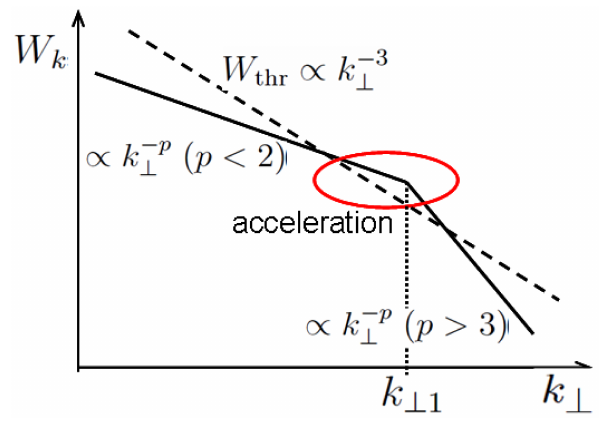
Fig. 3. Typical Alfv´enic turbulent spectrum (solid line) in the weakly/mildly dispersive KAW range and a “threshold” turbulent spectrum (dashed line) required for non-adiabatic ion acceleration. Non-adiabatic acceleration is possible around the first spectral kink, where the turbulent spectral power rises above the threshold spectral